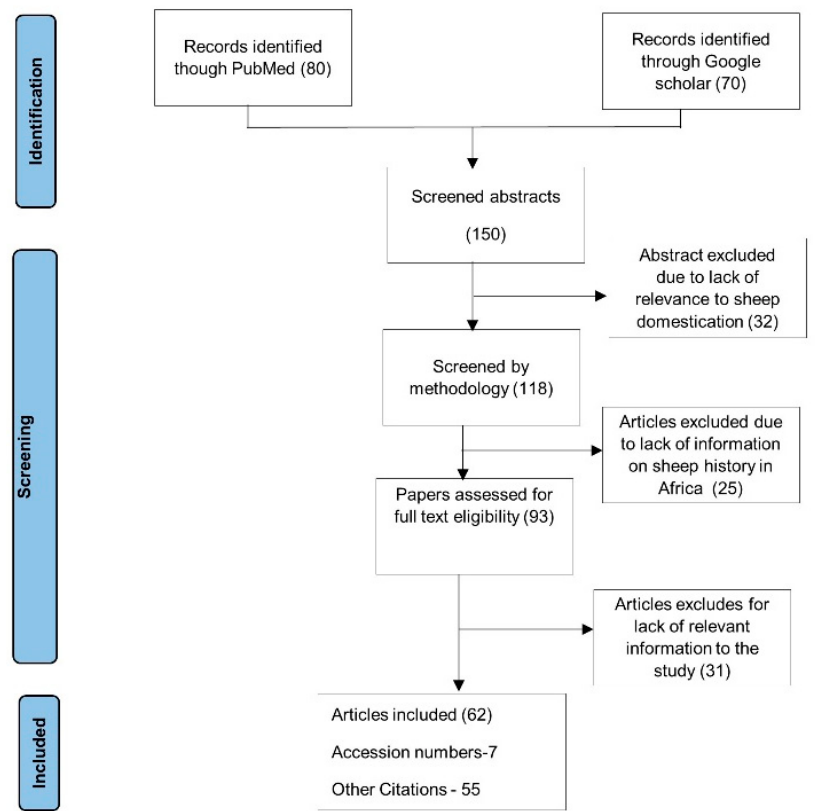
Figure 1. PRISMA (Preferred Reporting Items for Systematic Review and Meta-Analysis) flow